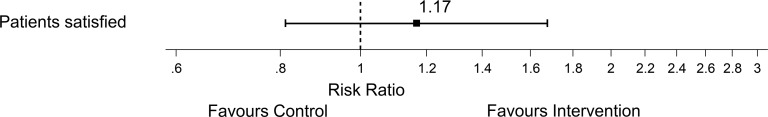
Point estimate and 95% confidence interval for the risk ratio for the patients being satisfied with the rehabilitation in the intervention group compared to the control group.